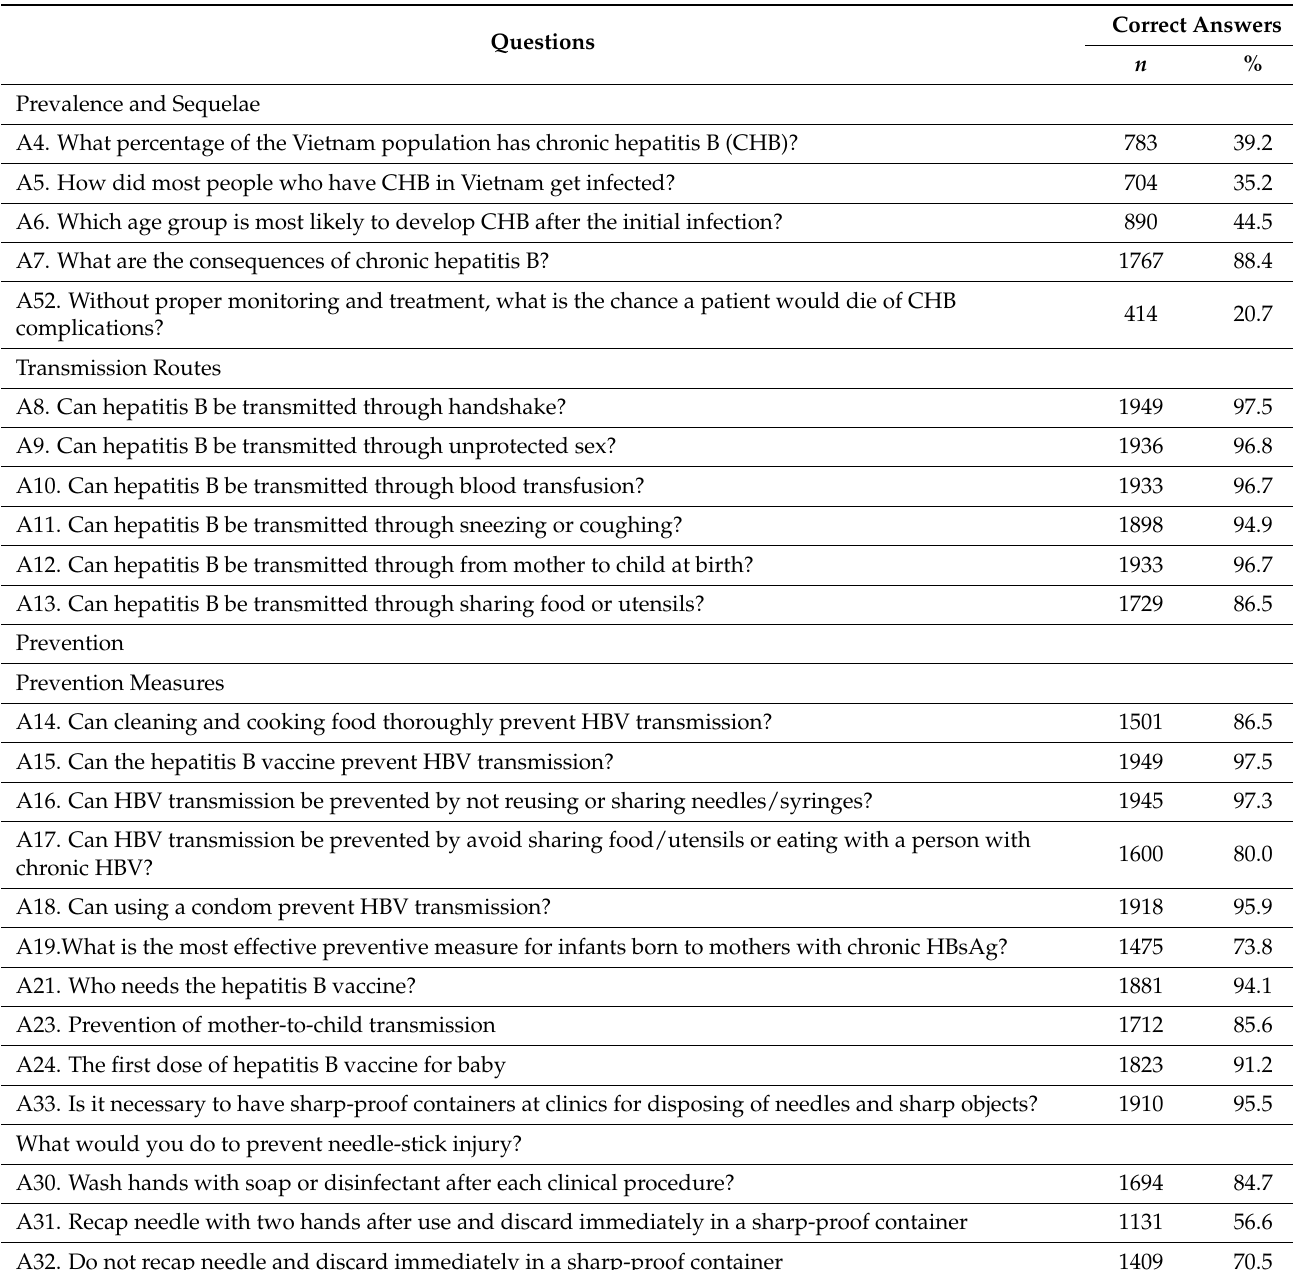
Table 2. Knowledge about HBV, prevention and treatment ( n =